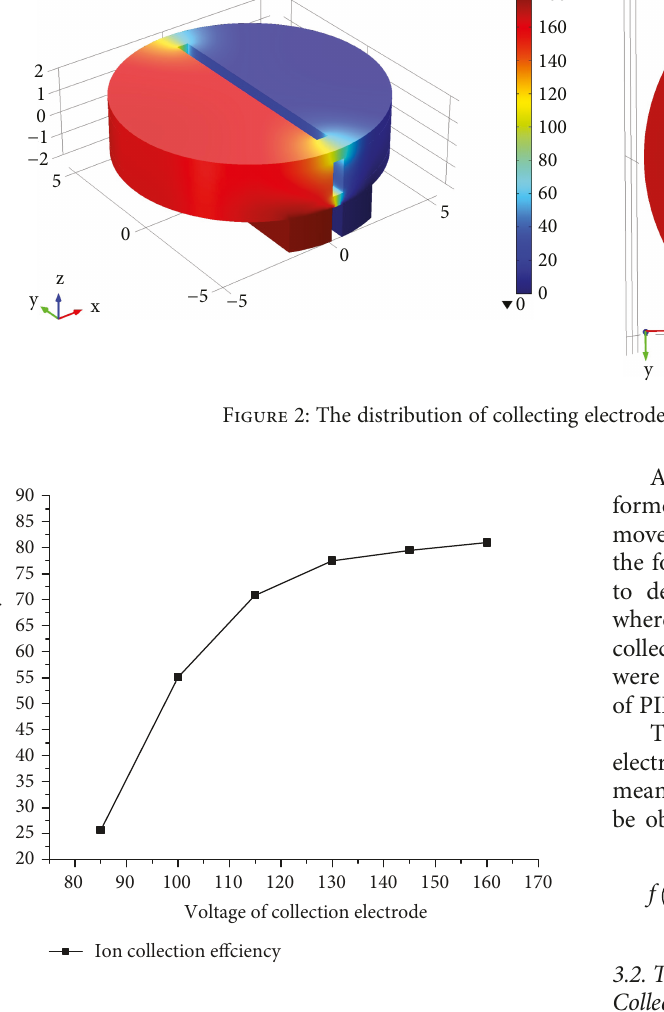
Figure 3: E ff ect of plate voltage of the collecting electrode on the charged ion collection e ffi